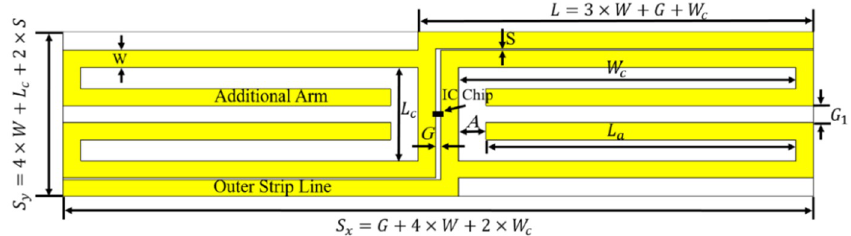
Figure 1. Geometry of the miniature folded dipole tag antenna   = 82.75 ,   = 19.5 ,   = 37.125 ,   = 11.1 ,  = 2 , A = 3 ,  = 0.2 ,  = 0.5 ,   = 2 (unit: